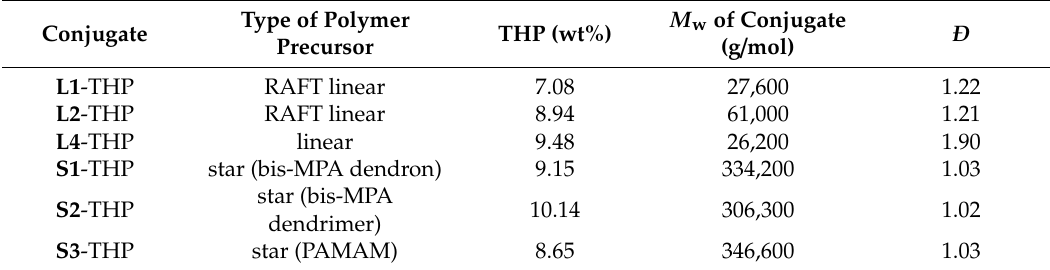
Table 2. List of polymer-drug conjugates and their characteristics.